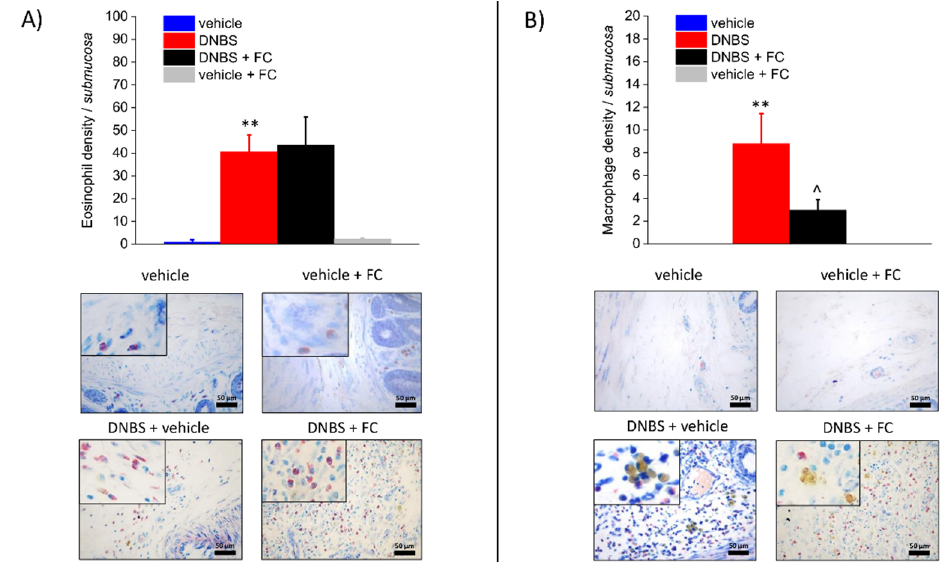
Figure 4. Effect of systemic fluorocitrate administration on submucosal eosinophils and activated macrophages increase induced by DNBS. The panel shows pictures captured from submucosa of eosinophils stained with GIEMSA ( A ) or foamy macrophages naturally stained by their yellow ‐ brown granules ( B ). Column graphs display the mean values of eosinophil or macrophage density per area of colonic wall (cells/field) ± S.E.M. obtained from 6 animals for each group. ** p < 0.01 vs. vehicle. ˆ p < 0.05 vs. DNBS. Original magnification: 40 × . Scale bar: 50 µ